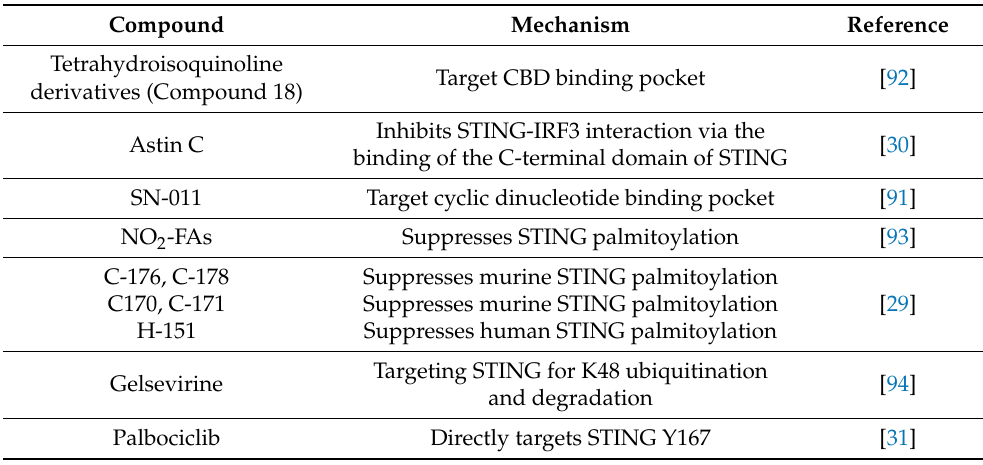
Table 1. Commonly used STING